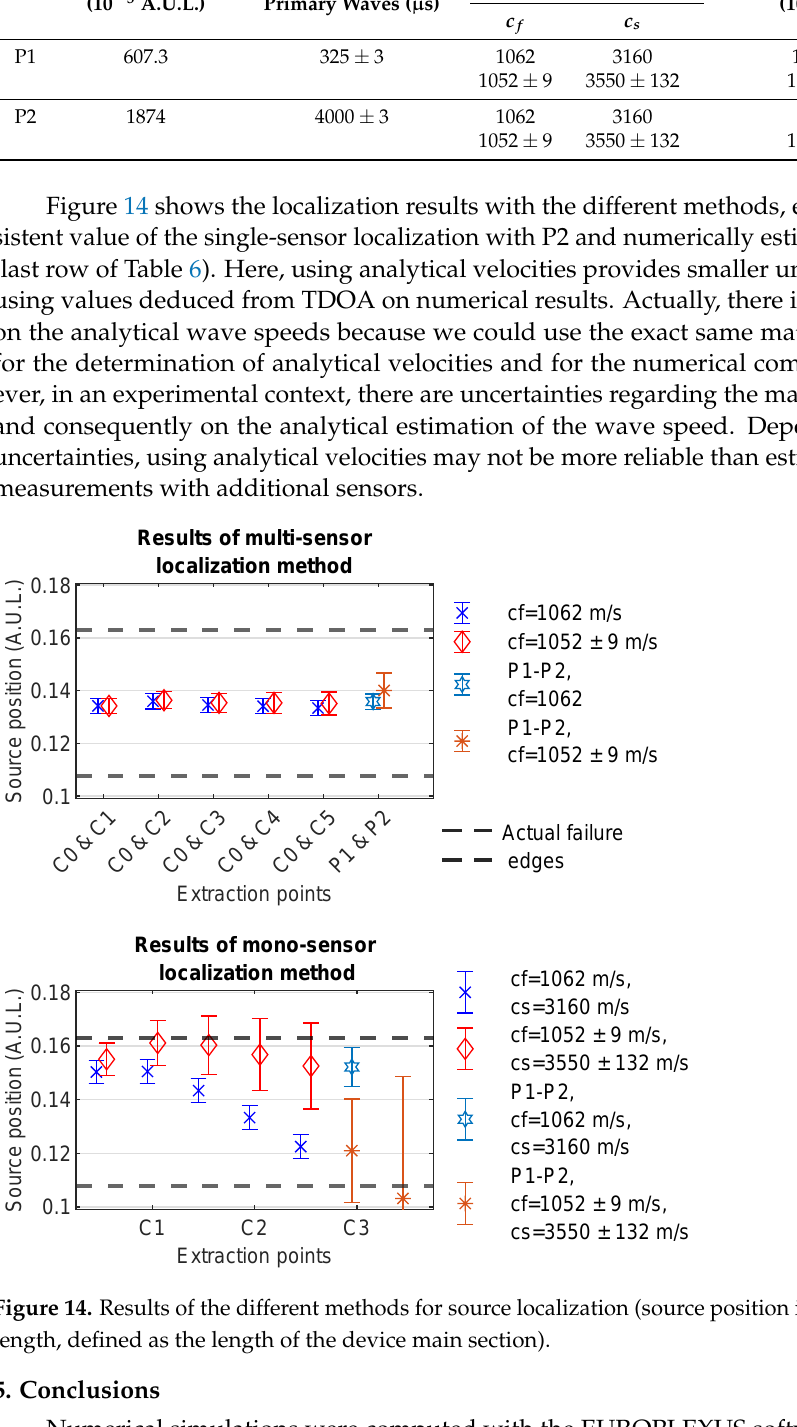
Table 6. Single-sensor localization with P1 or P2—results (actual source position: 135.3 × 10 − 3 A.U.L.). Point’s Position Point (10 − 3 A.U.L.)